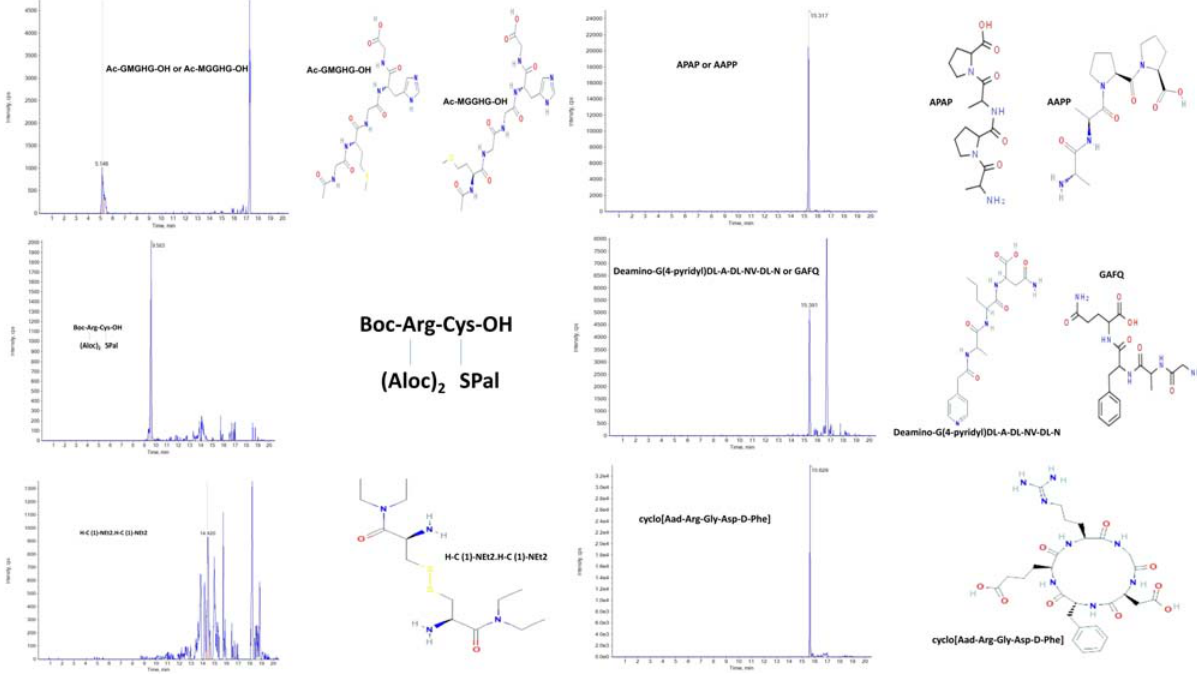
Figure 4: The LC - MS spectra of the short and cyclic peptides in the Acacia hamulosa honey sample. Five short peptides were found; Ac - GMGHG - OH or Ac - MGGHG - OH, Boc - R ( Aloc ) 2 - C ( Pal )- OH, H – C ( 1 )- NEt2 · H – C ( 1 )- NEt2, APAP or AAPP, and deamino - G ( 4 - pyridyl ) DL - A - DL - NV - DL - N or GAFQ. The cyclic peptide: cyclo [ L - alpha - homoglutamyl - L - arginyl - glycyl - L - alpha - aspartyl - D - phenylalanyl ] ( cyclo [ Aad - Arg - Gly - Asp - D - Phe ]) . The molecular structures of the studied compounds were cited from [ 20 – 28 ]